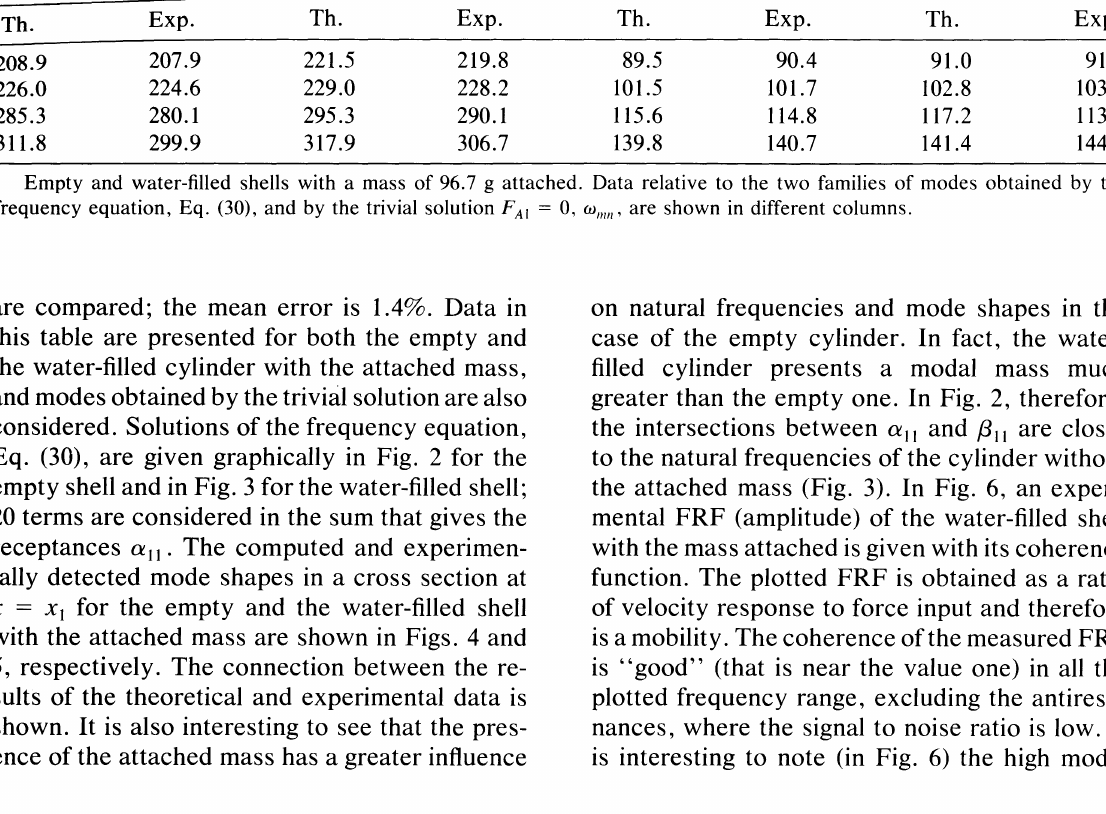
Table 1. Theoretical (Th.) and Experimental (Exp.) Natural Frequencies Empty Shell Water-Filled Shell Eq. (30) Wmn Eq. (30) Wmn Th. Exp. Th. Exp. Th. Exp. Th. Exp.